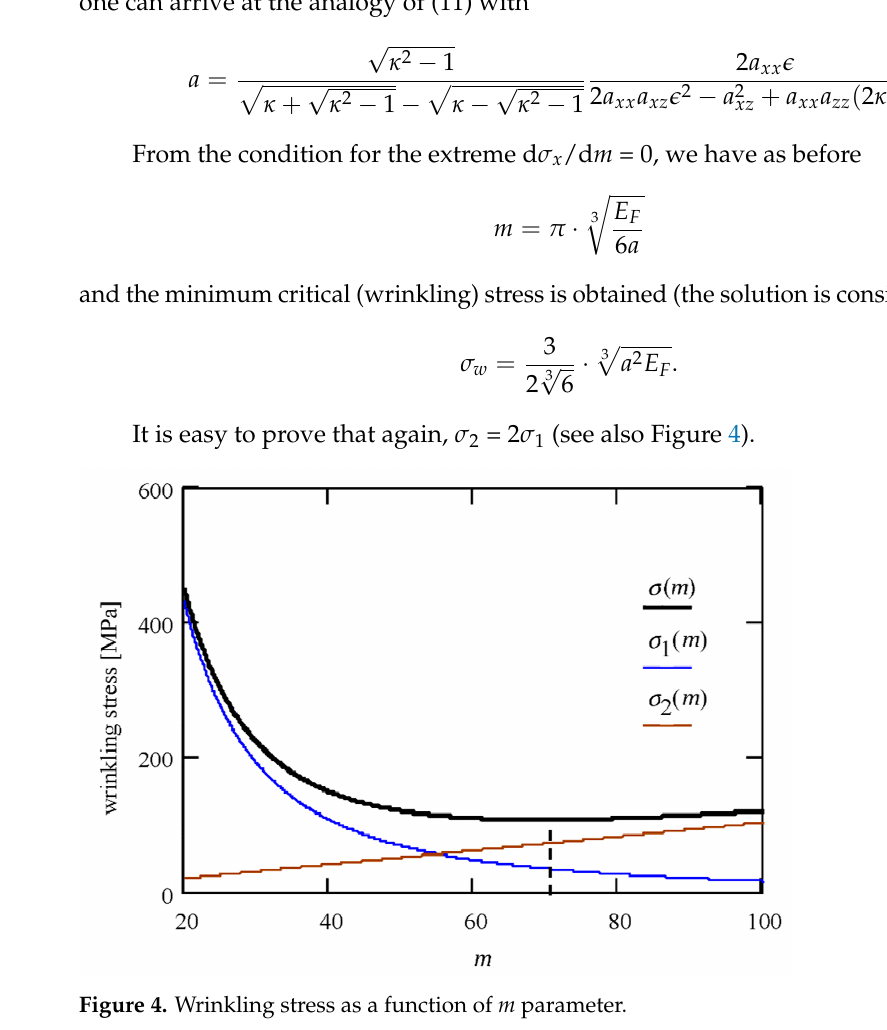
Figure 4. Wrinkling stress as a function of m parameter.